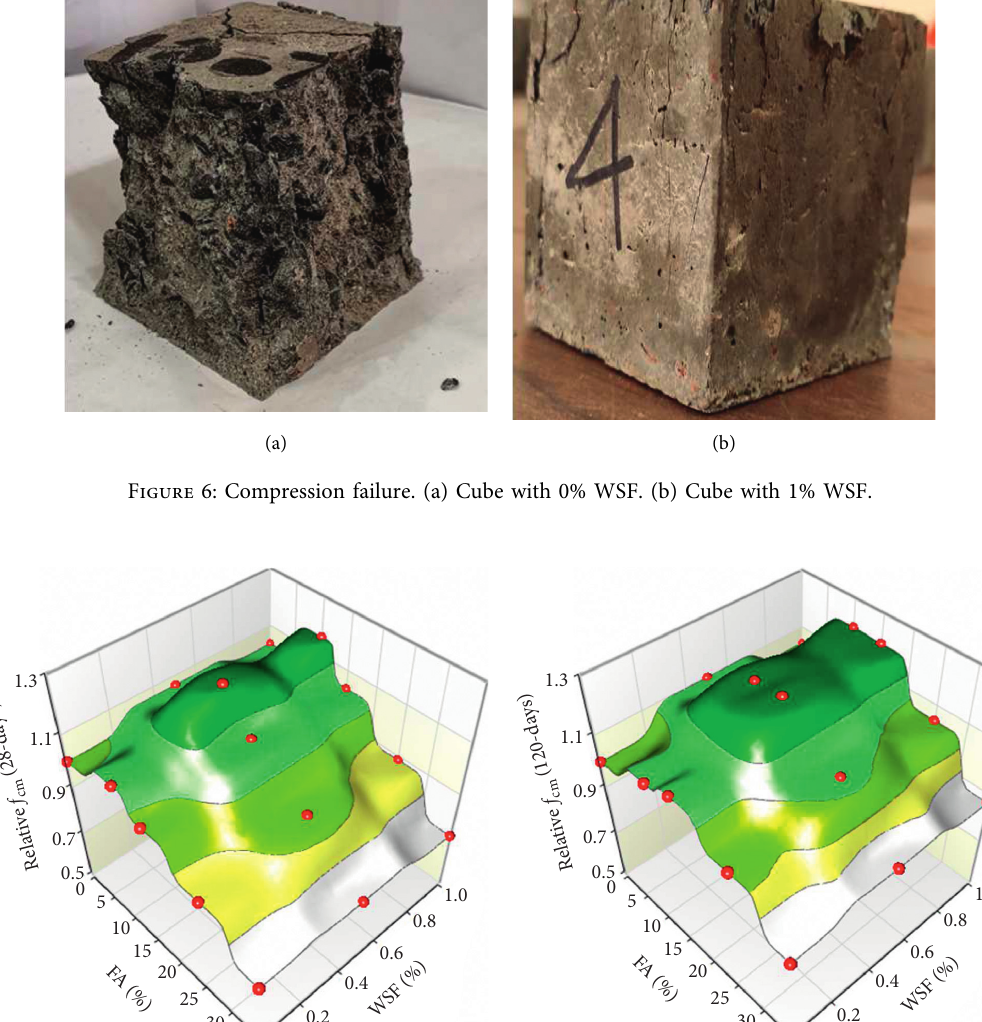
CM values of HSC: (a) 28 days and (b) 120